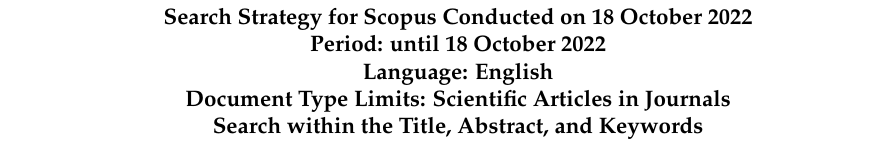
Table 1. Results of the combination of keywords in the iterative process.